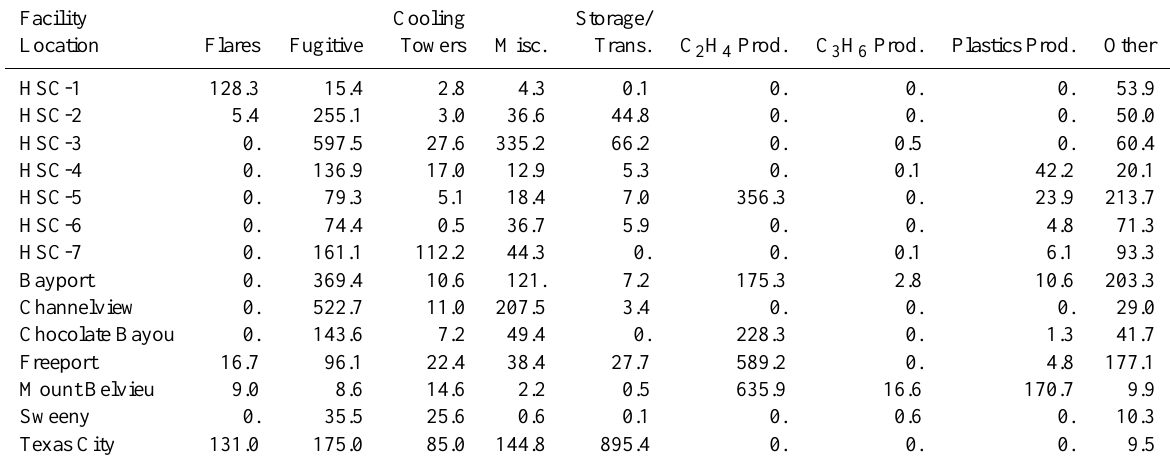
Table 9. Diurnally averaged ethylene emissions (moleh − 1 ) from the NEI-2005 inventory for the 14 locations with ethylene emissions reported in Mellqvist et al. (2010) and for the eight emission categories given in Table 8. “HSC” refers to the 7 Mellqvist et al. (2010) sectors within the Houston Ship Channel. “Other” refers to additional emissions at each location not within the eight emission categories.